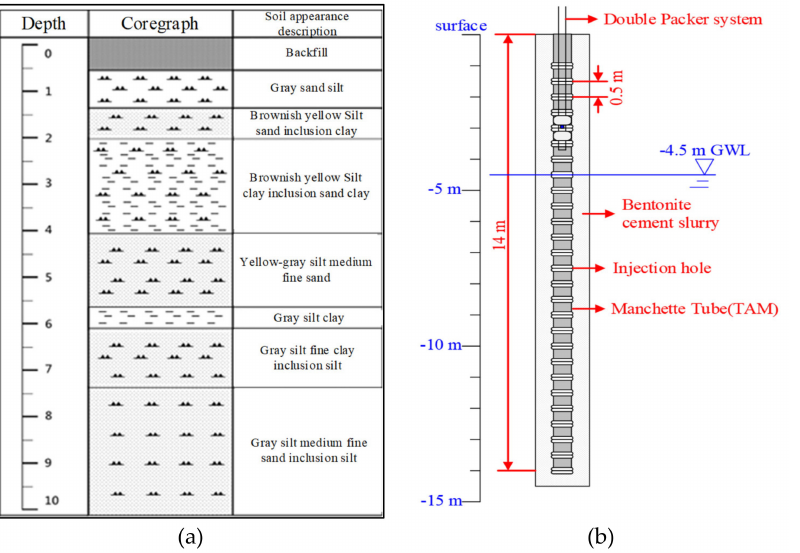
Figure 2. In situ geological structure and layered formation of the injection well: ( a ) in situ biological field geologic structure; ( b ) double packer injection well